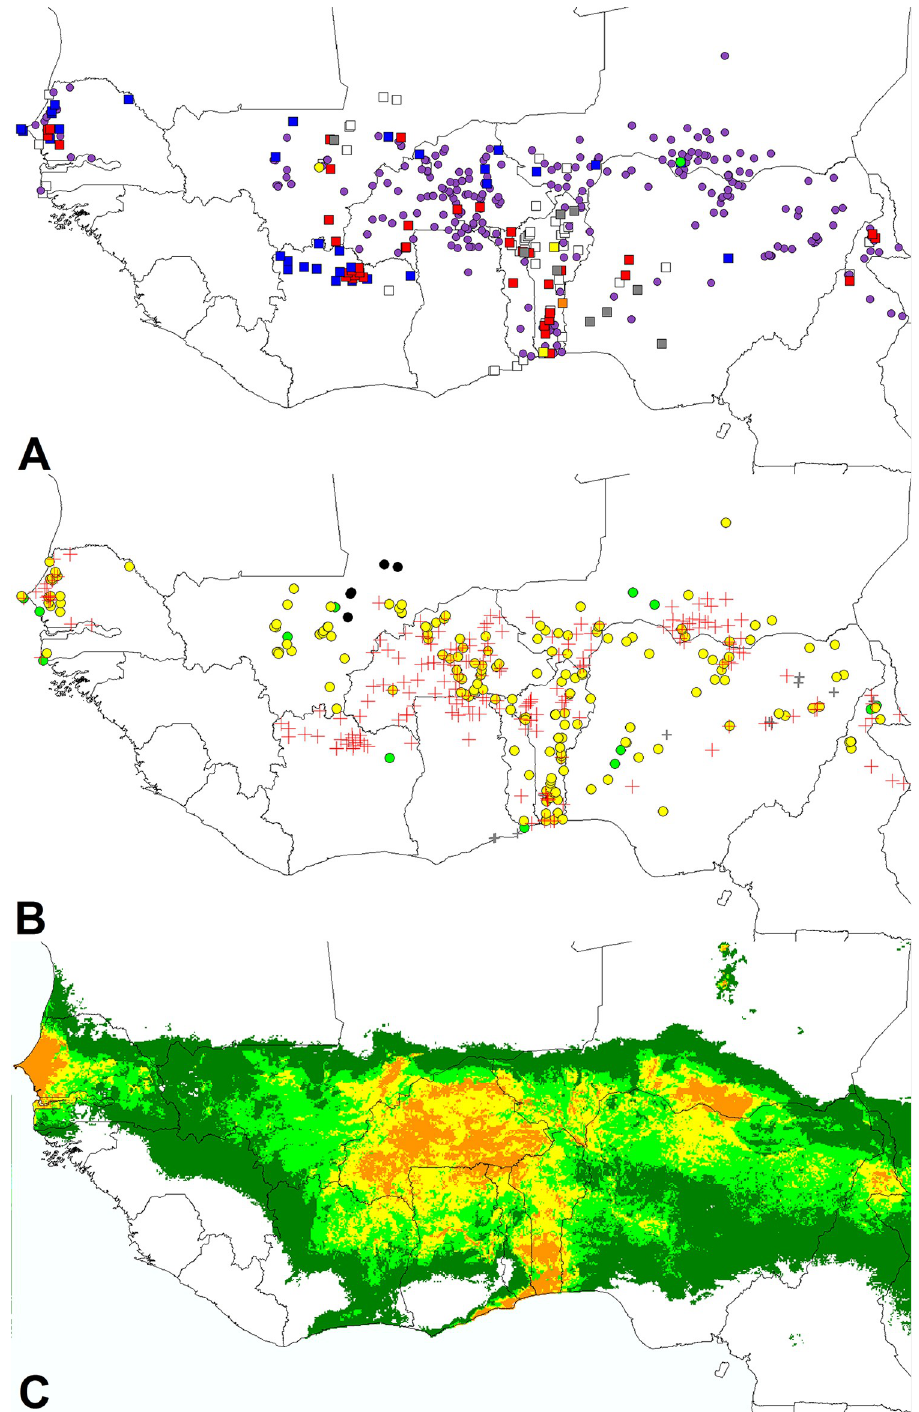
Fig 3. Distribution of S . gesnerioides records and derived distribution model. A. Occurrence records categorized by host species: cowpea (pink circles), wild Fabaceae (red squares), wild Convolvulaceae (blue squares), Poaceae (yellow squares, for Andropogon , and circle, for Pennisetum ), Anagalis pumila and Cyanotis lanata (orange squares), indeterminate wild hosts (grey squares) and indeterminate hosts in indeterminate environment (white squares). B. Occurrence records categorized by decadal or bidecadal period of observation: 1899–1909 (black circles), 1960–1980 (green circles), 1980–2000 (yellow circles), 2000–2020 (red crosses), unknown date (grey crosses). C. Maxent ecoclimatic distribution model derived from these observations (color code as for Fig